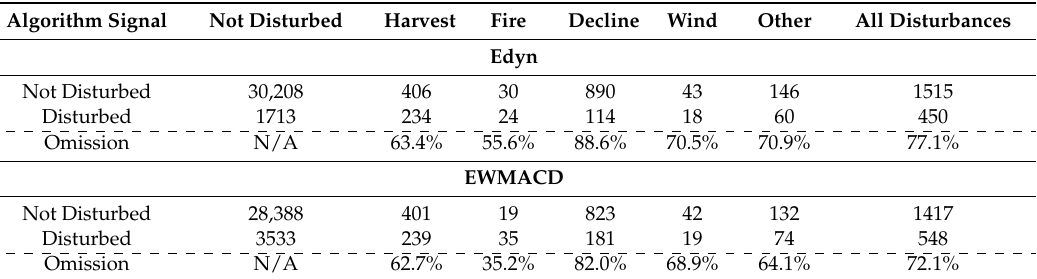
Table 4. Annualized disturbance/non-disturbance Edyn/EWMACD agreement with TimeSync for the 1800 pixels used in Cohen et al., 2017 [14], partitioned across TimeSync disturbance classes. Direct comparison may be made to Table 3 of